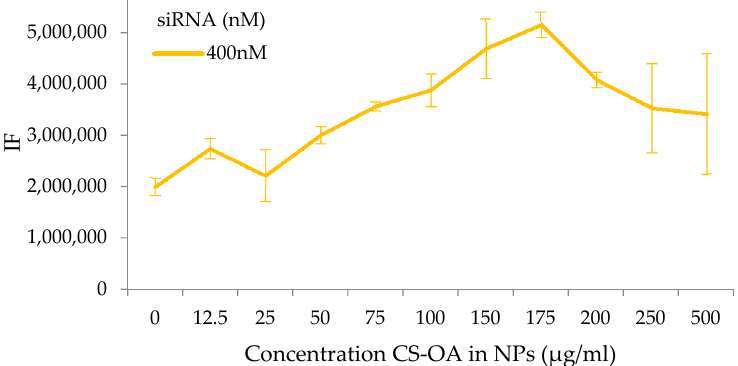
Figure 3. Fluorescence intensity of FITC-siRNA at different concentration of CS-NPs (mean values ± s.d., n = 8) for siRNA concentration of 400 nM.